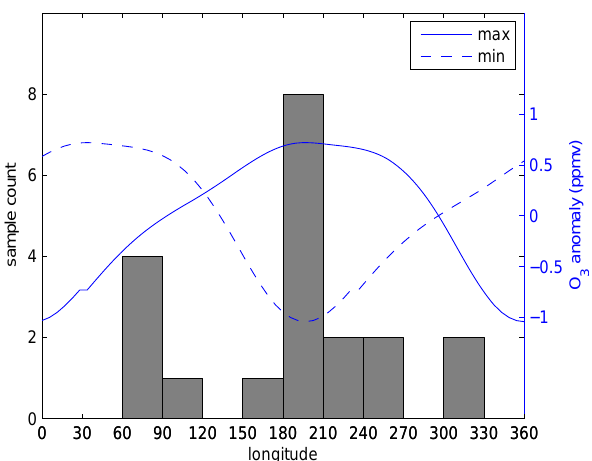
Fig. 9. Zonal ACE-FTS sampling distribution for March within the 70–75 ◦ S latitude bin (gray bars). Also shown is the monthly mean zonal O 3 anomaly field at 74.7 ◦ N, at 10hPa. The O 3 field has been shifted in longitude to produce maximum (solid) and mini- mum (dashed) values of a weighted mean of the O 3 field using the sample distribution as